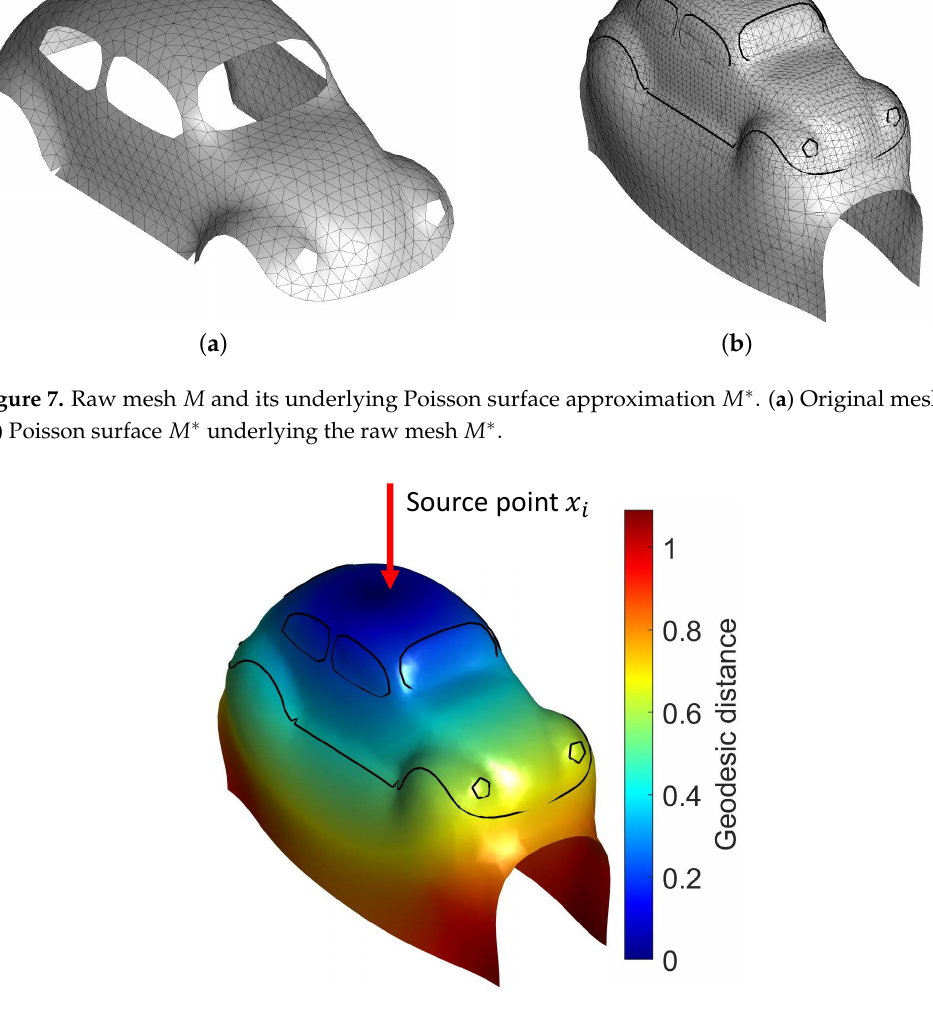
Figure 8. Geodesic distance estimation on the Poisson surface M ∗ approximating raw mesh M